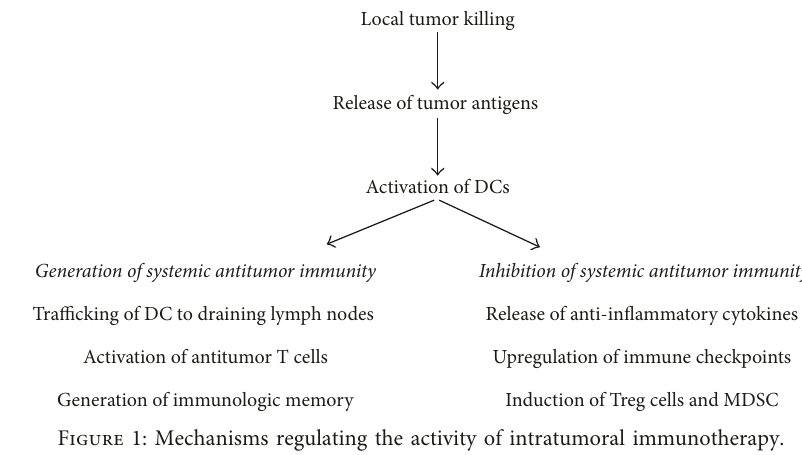
Figure 1: Mechanisms regulating the activity of intratumoral